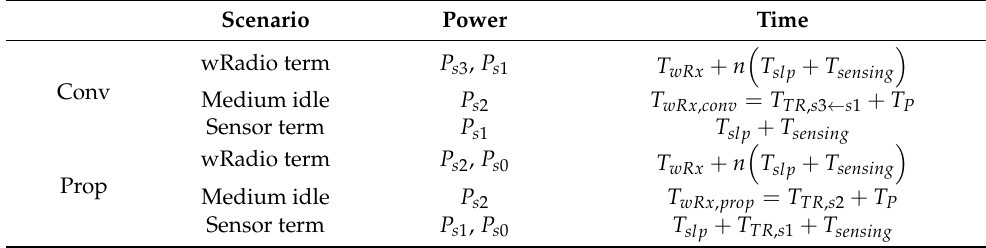
Table 4. Power states and Time used in the sleep